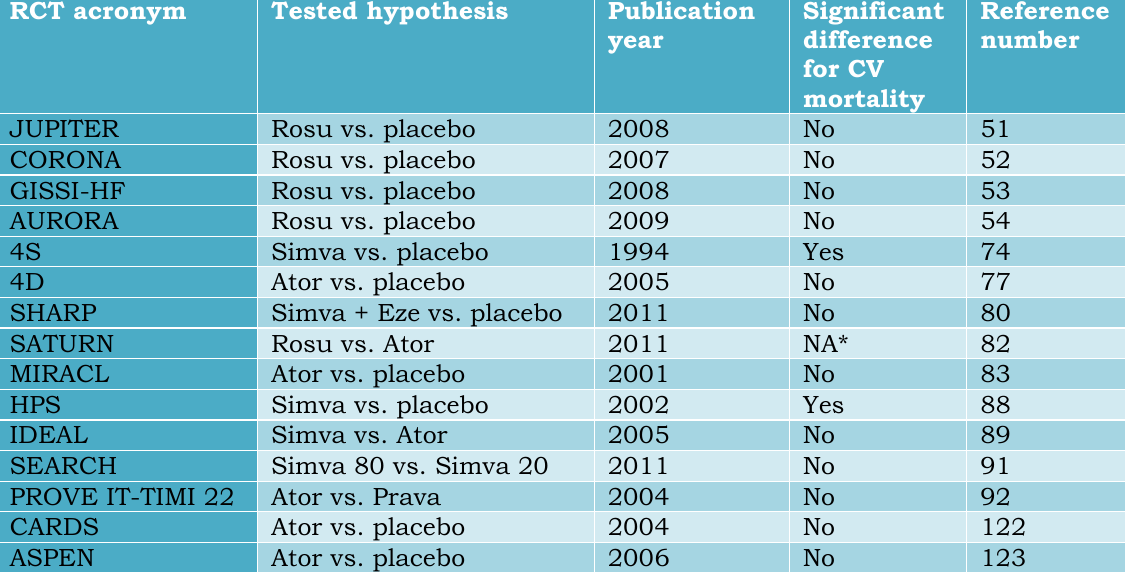
Table 1. List of the main RCTs discussed in this review in the order of appearance in the